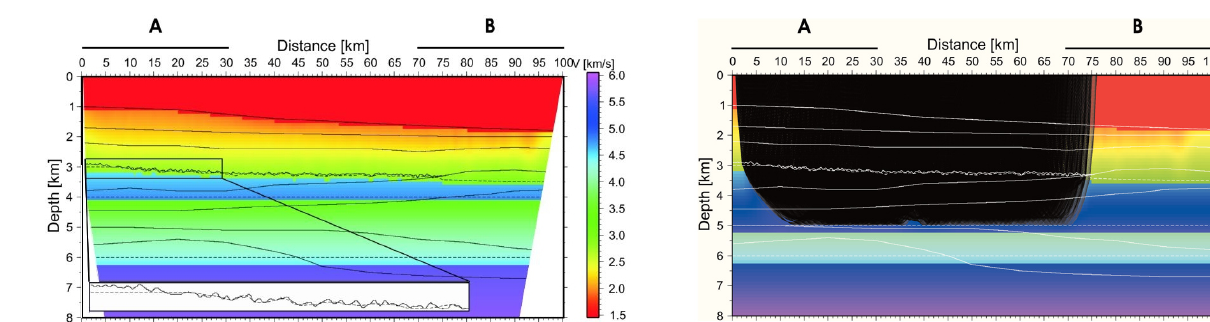
Fig. 4. Velocity model obtained using TTT package Trinks et al. (2005) after inverting refractions from the sediments over the basalt and reflections from the top of the basalt layer. Dashed lines represent layers from inversion and continous lines the theoretical layer interfaces. Note the coincidence between dashed line and continous line in the top of the basalt layer.The unresolved parts of the model at both ends of the transect are determined from forward modelling, ray tracing.